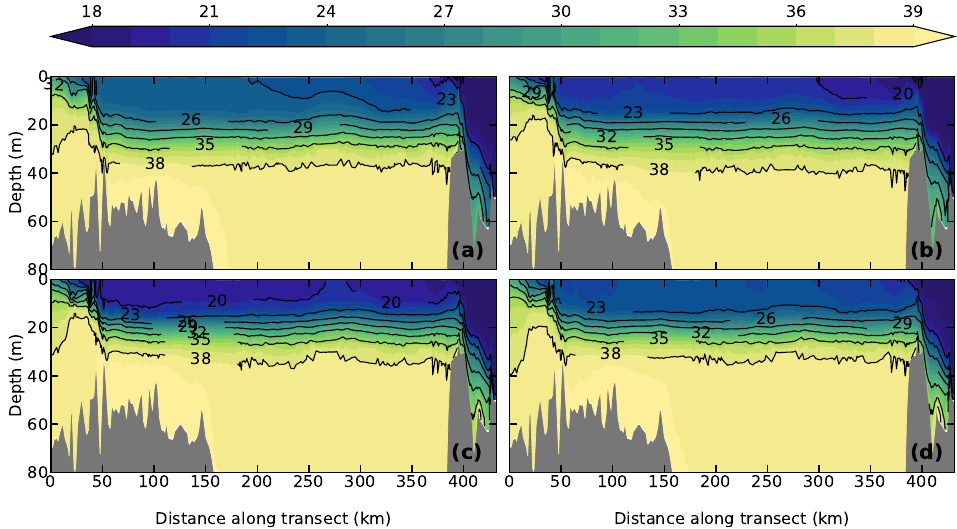
Figure 11. Same as in Figure 10, for salinity. ( a ) Winter JFM, ( b ) spring AMJ, ( c ) summer JAS, and ( d ) autumn OND. Table 4. Average two-layer (upper/lower) and net volumetric flow and standard deviation of flow at the Dardanelles and Bosphorus straits for the EMBS simulation and the box-model of Maderich et al. Comparison for the common period is first shown, while the additional comparison with observations at Dardanelles from Jarosz et al. is included for the period 2008–2009.